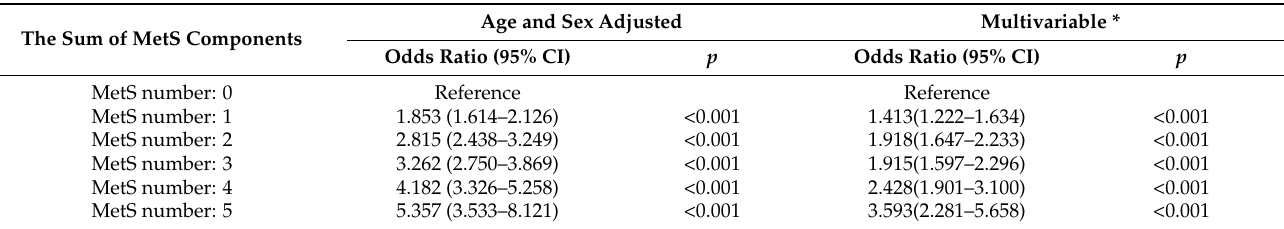
Table 3. Associations between the sum of MetS components and new-onset hyperuricemia, deter- mined using logistic regression analysis.